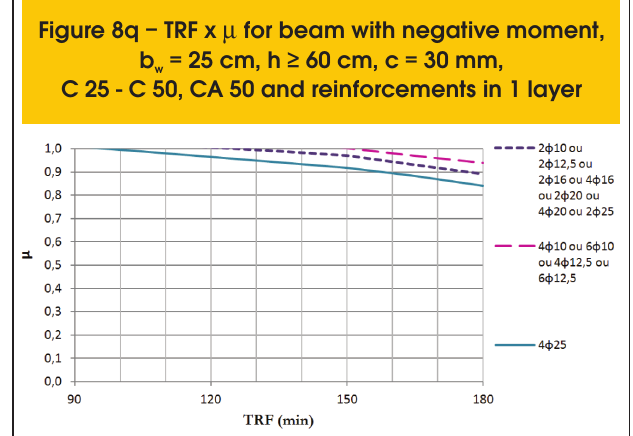
Figure 8q – TRF x m for beam with negative moment, b = 25 cm, h ≥ 60 cm, c = 30 mm, w C 25 - C 50, CA 50 and reinforcements in 1 layer